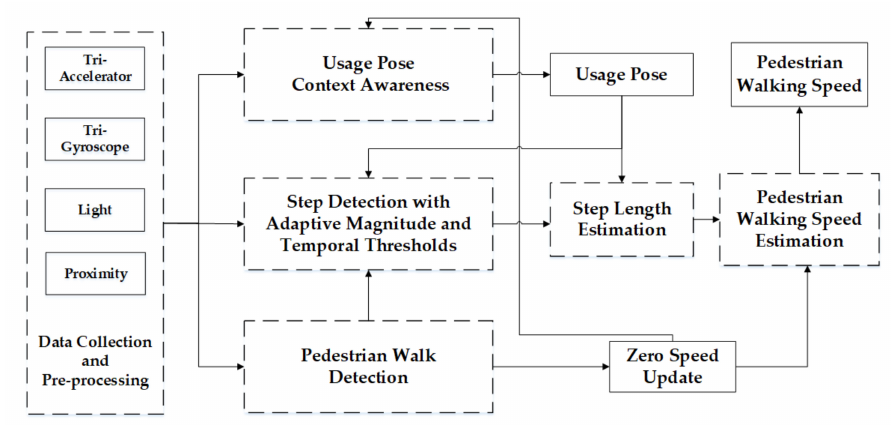
Figure 1. Scheme of speed estimation.